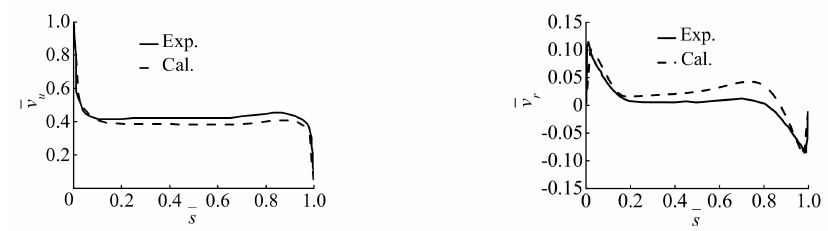
Figure 9. Comparison of numerical results and test results.